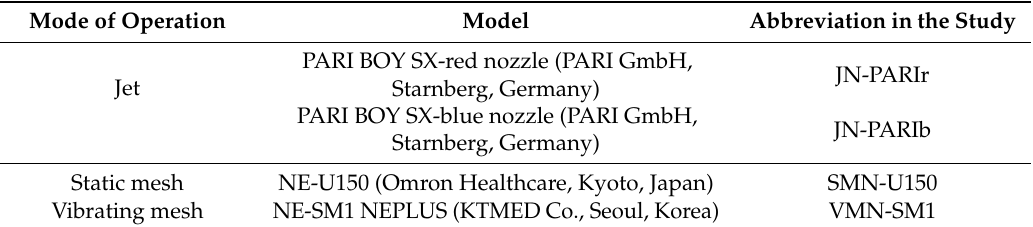
Table 1. Nebulizers used in the